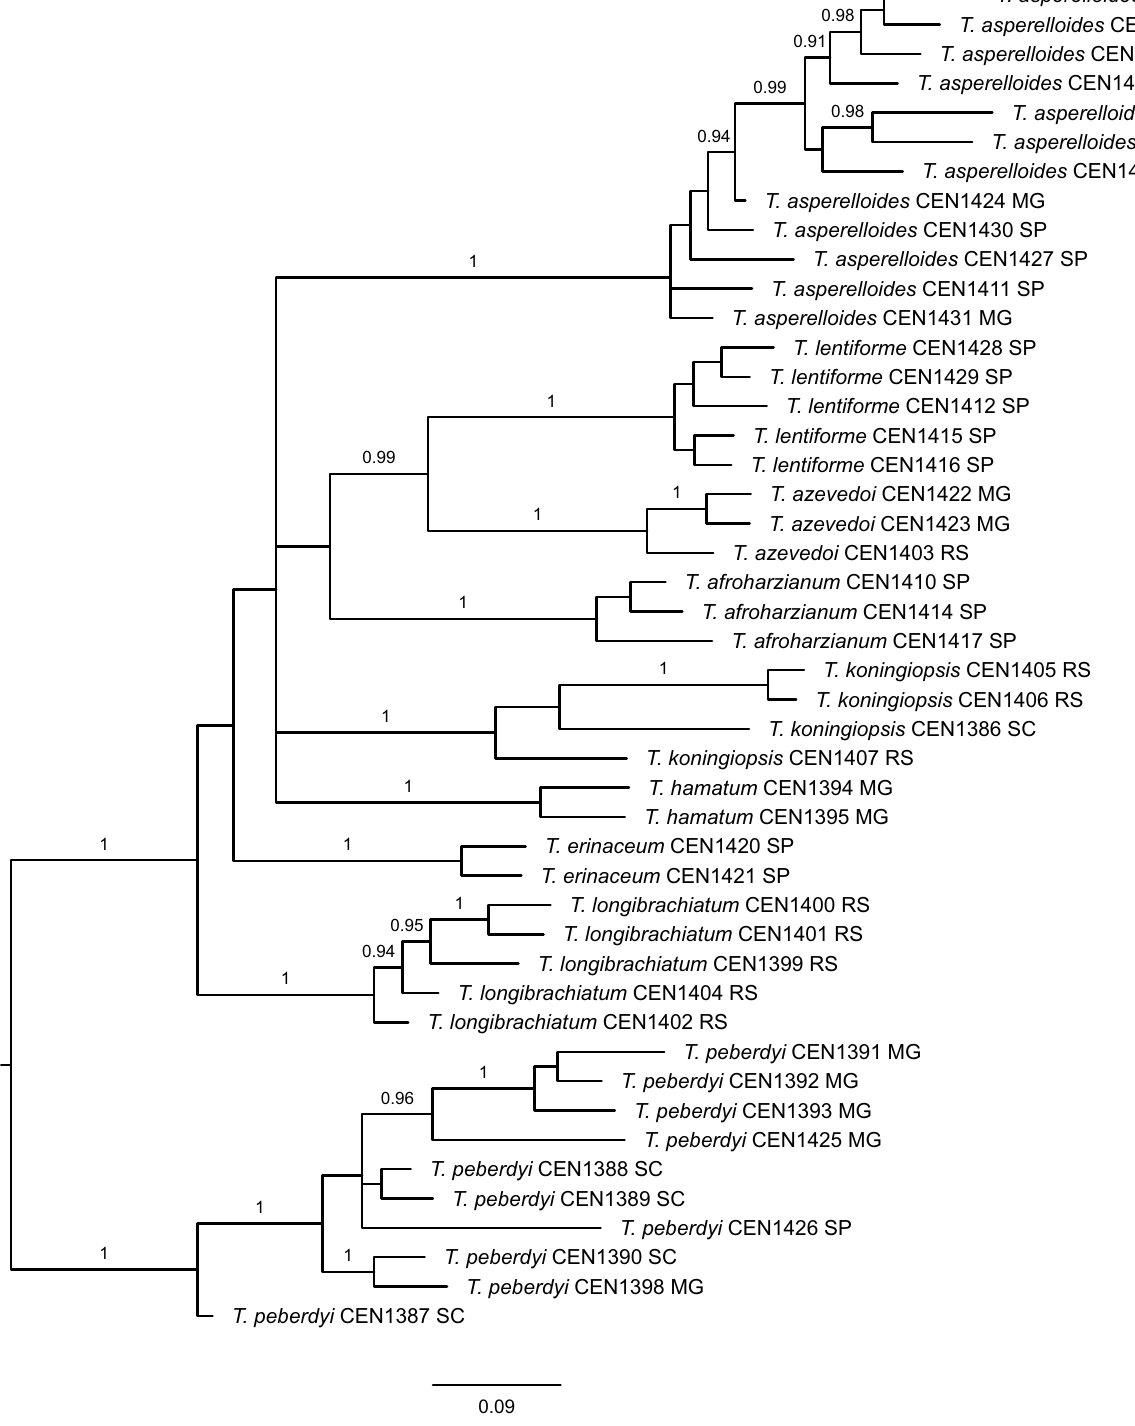
Fig 5. AFLP midpoint rooted Bayesian phylogram. Posterior probabilities are given above branches ( > 0.9) and the scale bar represents expected changes per site. Species names are followed by strain number and collection location by Brazilian state.